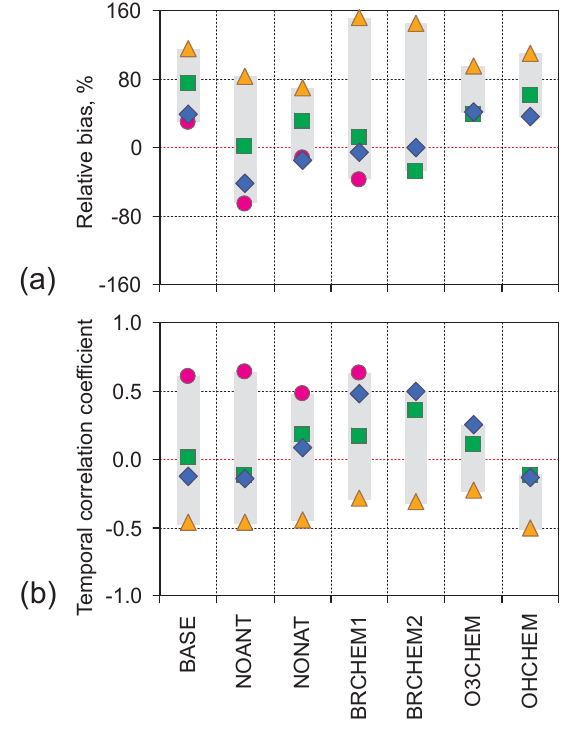
Figure 6. Relative bias (a) and spatial correlation coefficient (b) of simulated and observed annual mean RM air concentration for different model